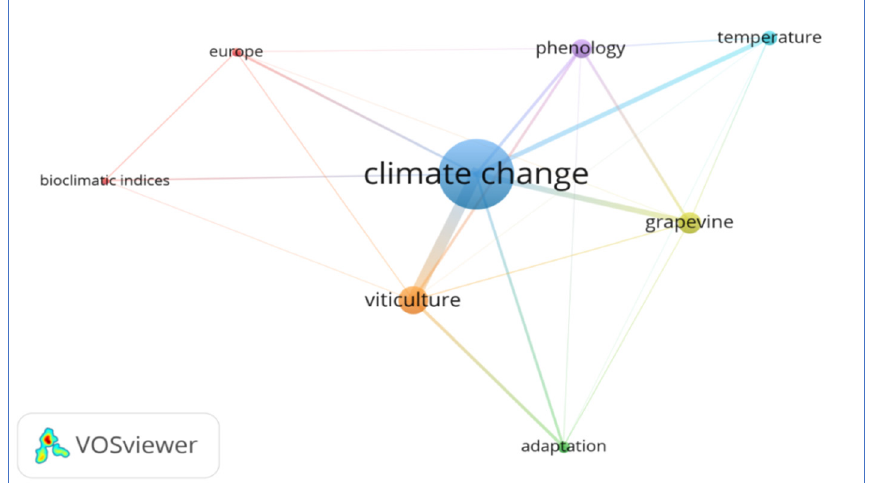
Figure 1. The citations’ network via the VOSviewer software.